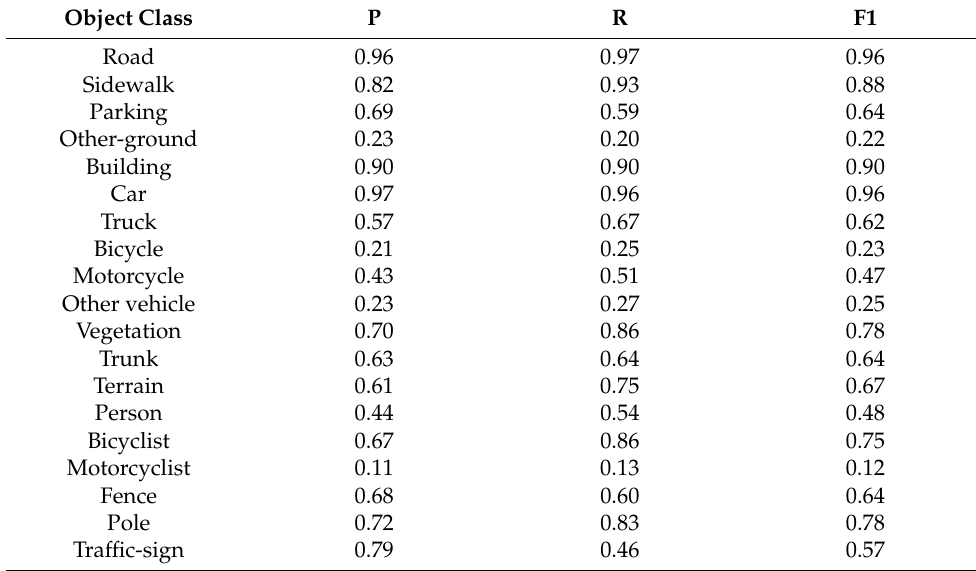
Table 4. Semantic segmentation performance of